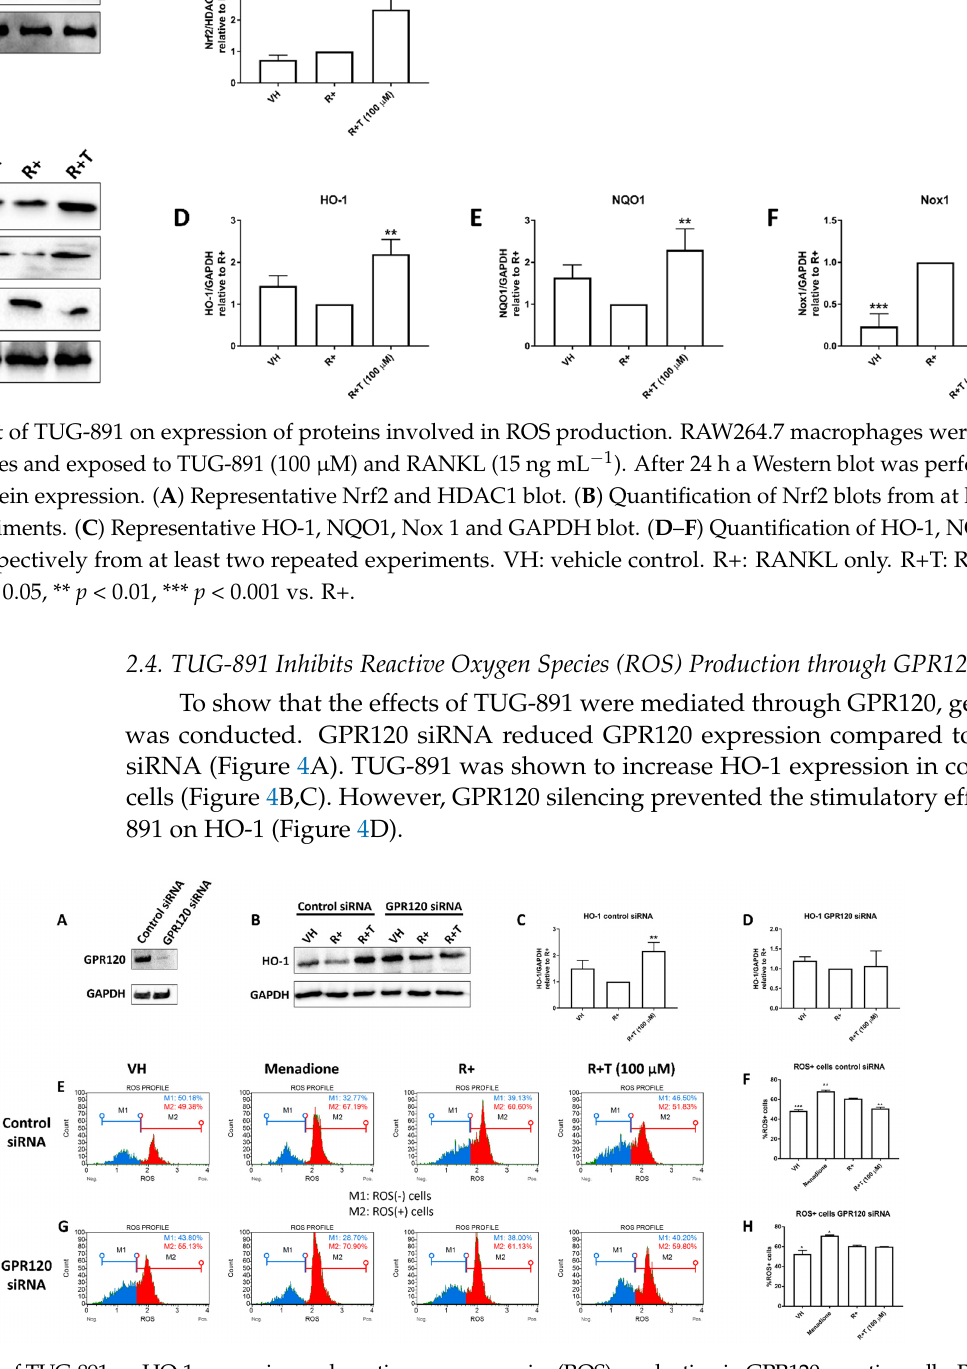
Figure 4. Effect of TUG-891 on HO-1 expression and reactive oxygen species (ROS) production in GPR120 negative cells. RAW264.7 macrophages were seeded into 6-well plates and exposed to TUG-891 (100 µM) and RANKL (15 ng mL − 1 ). Cells were exposed to control siRNA or GPR120 siRNA for 24 h. ( A ) GPR120 expression was determined by Western blot. ( B ) The expression of HO-1 was determined. Representative HO-1 and GAPDH blot is shown. ( C , D ) Quantification of HO-1 blots for control siRNA and GPR120 siRNA transfected cells respectively from at least two repeated experiments. ( E ) After 48 h intracellular ROS was determined using a Muse ® Oxidative Stress Kit Menadione (100 µM) was used as a control for intracellular ROS production. Representative ROS profiles for control siRNA cells are shown. ( F ) Percentage of ROS positive cells in control siRNA cells from two experiments. ( G ) Representative ROS profiles for GPR120 siRNA transfected cells. ( H ) Percentage of ROS positive cells in GPR120 siRNA cells from two experiments. VH: vehicle control. R+: RANKL only. R+T: RANKL + TUG-891. * p < 0.05, ** p < 0.01, *** p < 0.001 vs. R+.